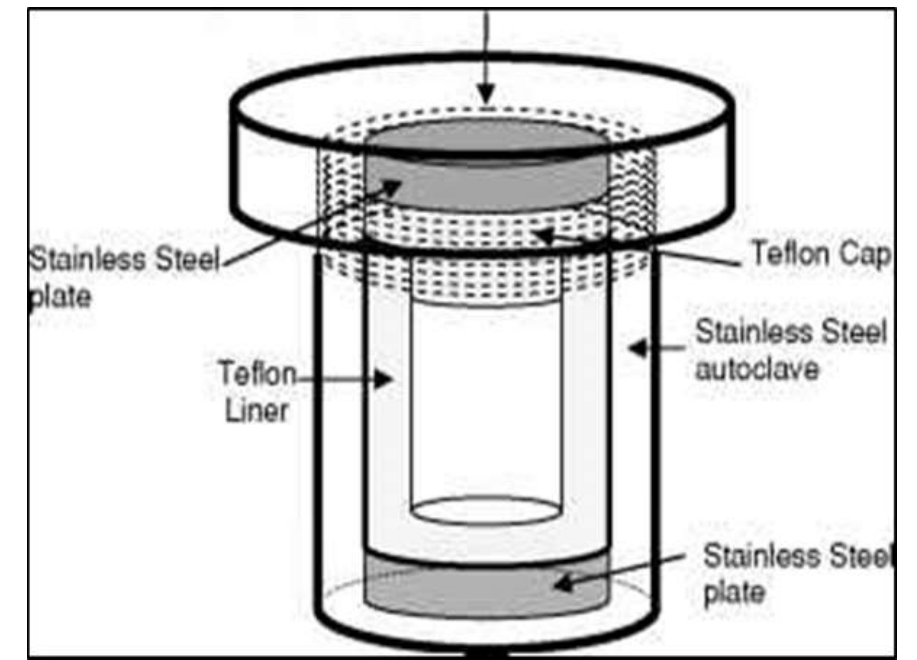
Figure 1: Hydrothermal autoclave parts use to prepare TiO